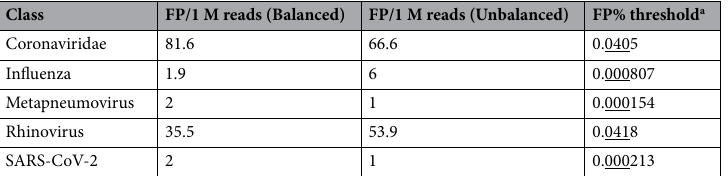
Table 2. Average false positive reads across 100 experiments for each viral class. FP = False positive, 1 M = 1 million, Balanced = 100 experiments with equal proportion of reads from each class, Unbalanced = Variable proportion of reads from all classes and no reads from the test class. a These thresholds represent 0.99 quantile for FP% for that